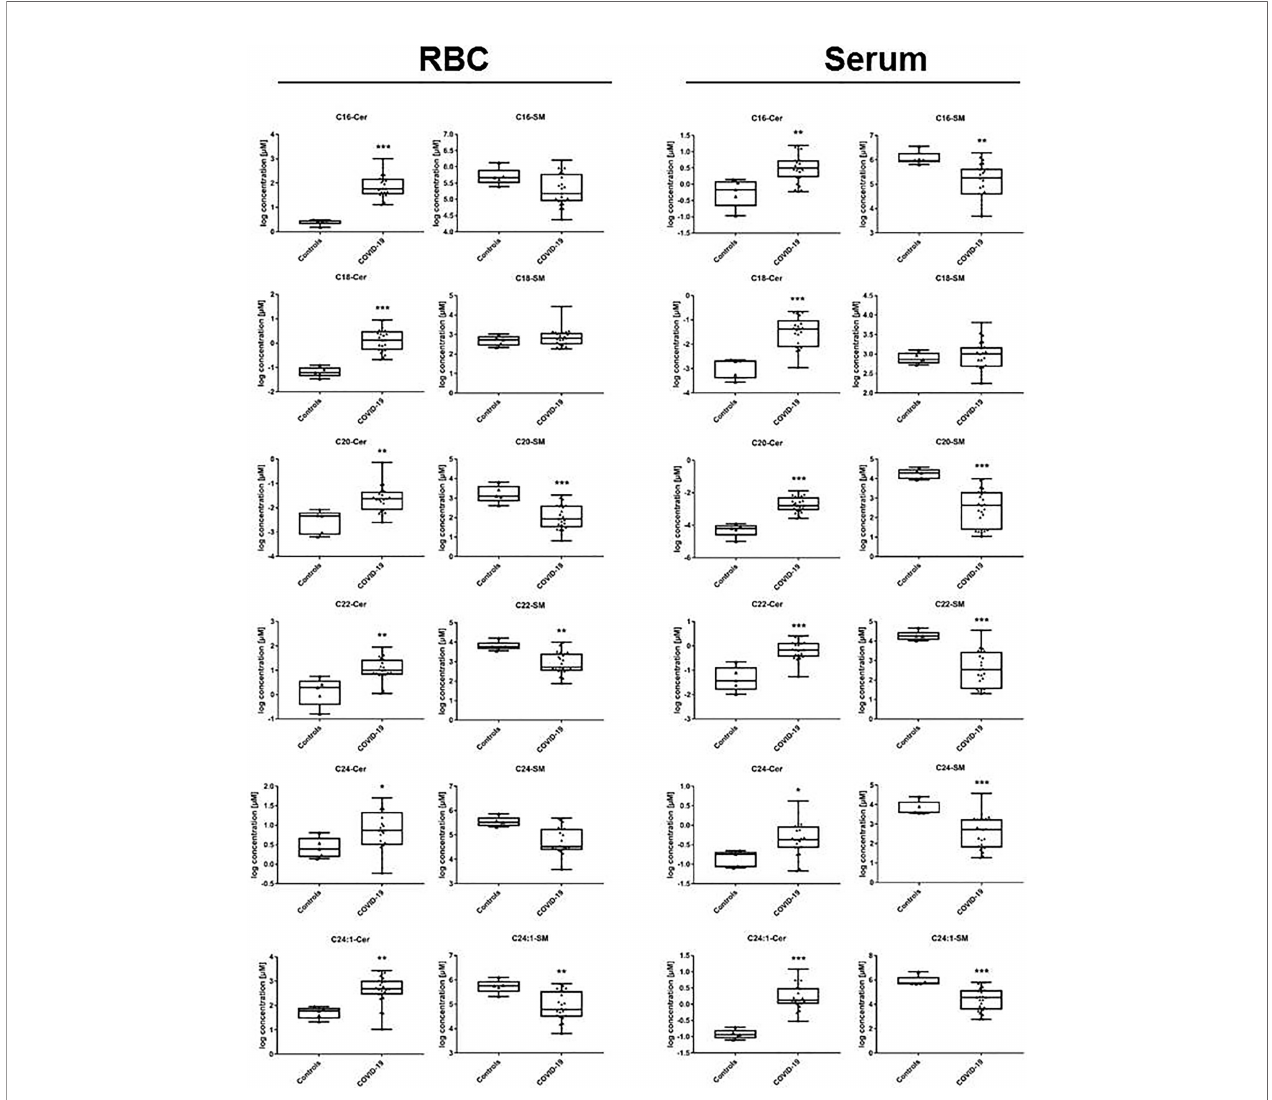
FIGURE 3 | Ceramide pro fi le in lipid extracts obtained from RBC and from serum samples. In patients with COVID-19, ceramide synthesis is increased in all specimen passing quality screen in RBC, and nearly in all investigated in serum (one exception: 24:0). Total amount of ceramide specimen is differing as expected between serum and RBC, absolute values are given in Table 3 . Statistical analysis was performed using Mann-Whitney U-Test and p-values <0.05 were considered to be signi fi cant. COVID-19 vs. healthy controls: *p < 0.05; **p < 0.01; ***p < 0.001. Exact parameters indicating statistical difference area also given in Table 2 .